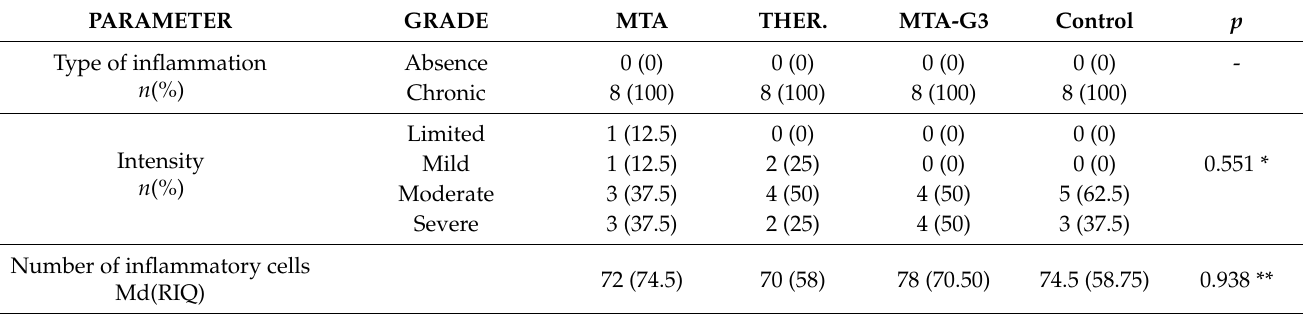
Table 4. Qualitative variables MTA, MTA-G3 and Theracal, 15